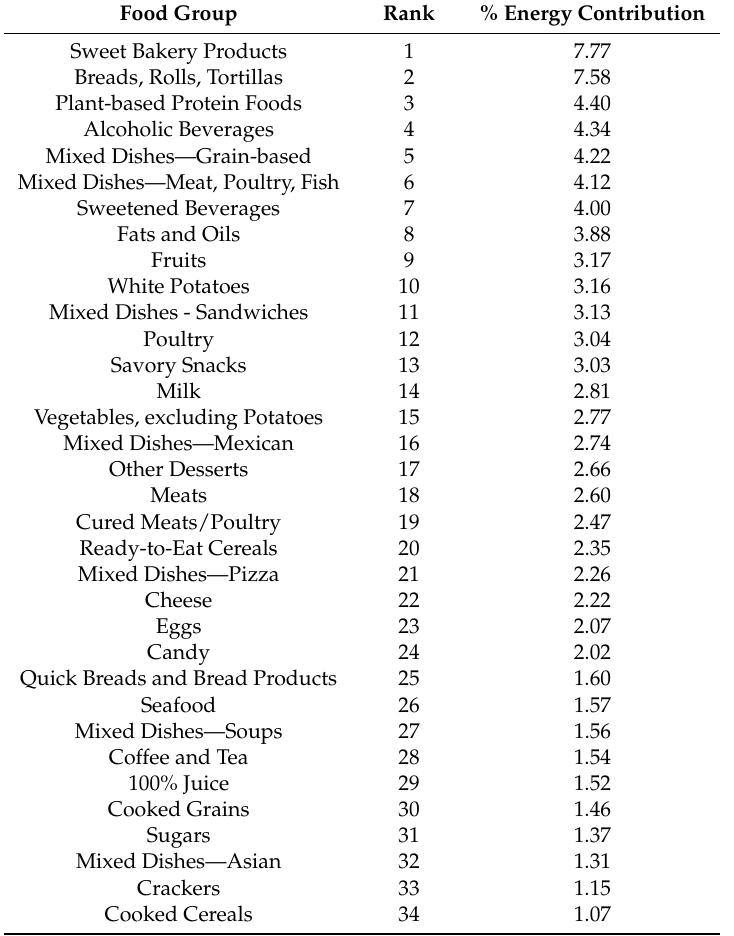
Table 2. Subcategory food group sources of energy (kcal) contribution in the total U.S. diet, adults ≥ 51 years old ( n = 4522; gender combined; daily intake data; NHANES 2011–2014; food subcategories contributing <1.0% not reported; data are Day 1